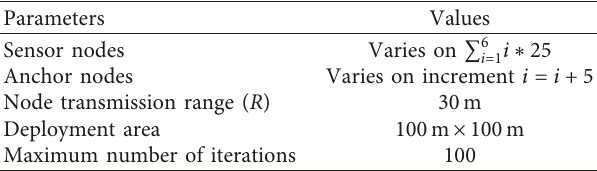
Figure 2: Pseudocode of the SSA algorithm. Table 1: Parameters setting of simulation